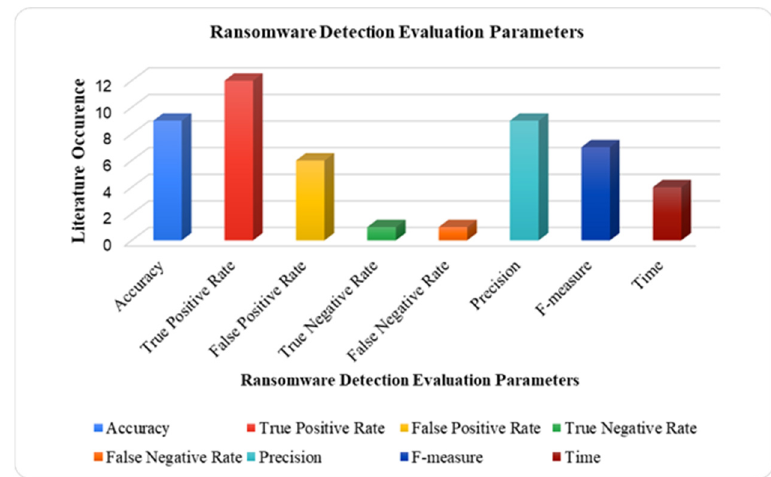
Figure 12. Ransomware detection outcomes.